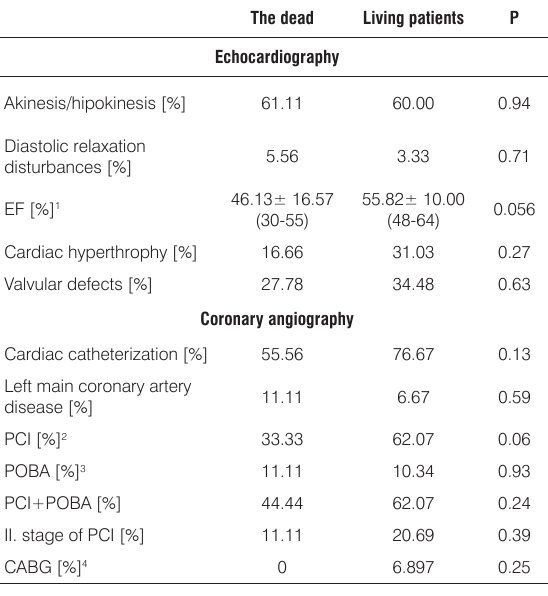
Table 3. Echocardiographic and angiographic characteristics of the studied groups.